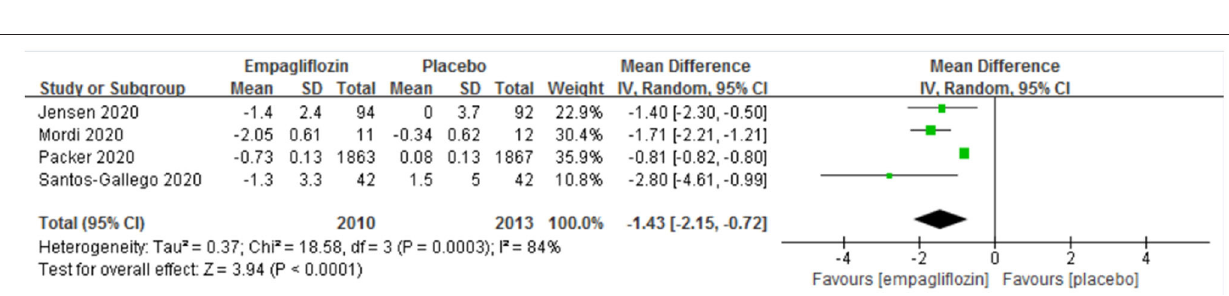
FIGURE 6 | Effect of empagliflozin on the change in Kansas City Cardiomyopathy Questionnaire (KCCQ) score from baseline.